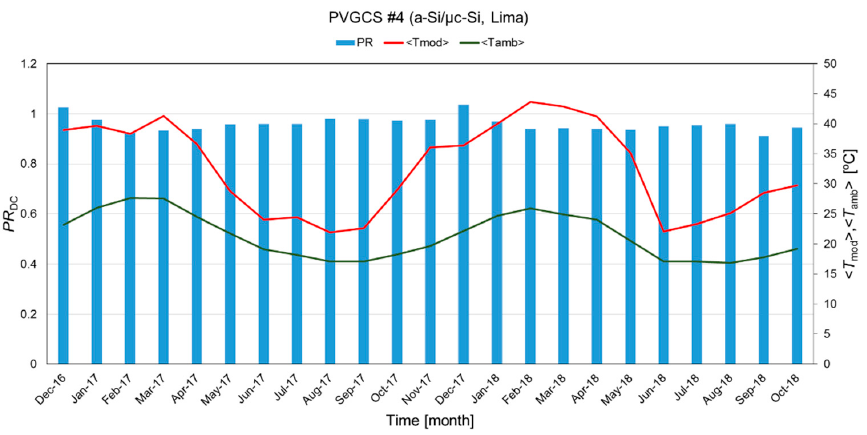
Figure 9. Values of PR DC , < T amb >, and < T mod > for PVGCS #4 over the period under scrutiny. N.B. only values of temperature recorded during daytime are considered in the calculations.